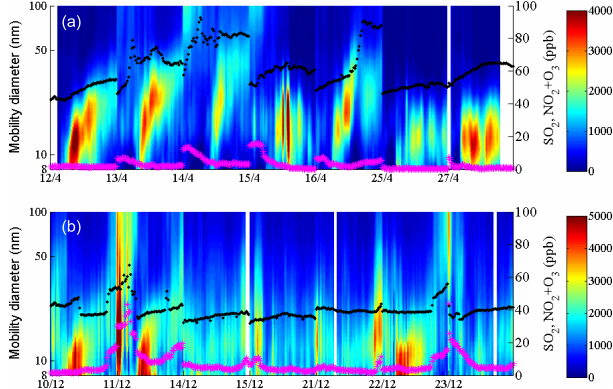
Figure 2. Contour plots of particle number concentration (#cm − 3 ) and time series of NO 2 + O 3 and SO 2 in the mixing ratio in two sea- sons ( a seven NPF events during 12–27 April 2012, b seven NPF events during 10–23 December 2011; there were only data from 08:00 to 18:00 on each day to be shown; full black diamonds and peak magenta stars represent the mixing ratios of NO 2 + O 3 and SO 2 , respectively, while the values correspond to the right y